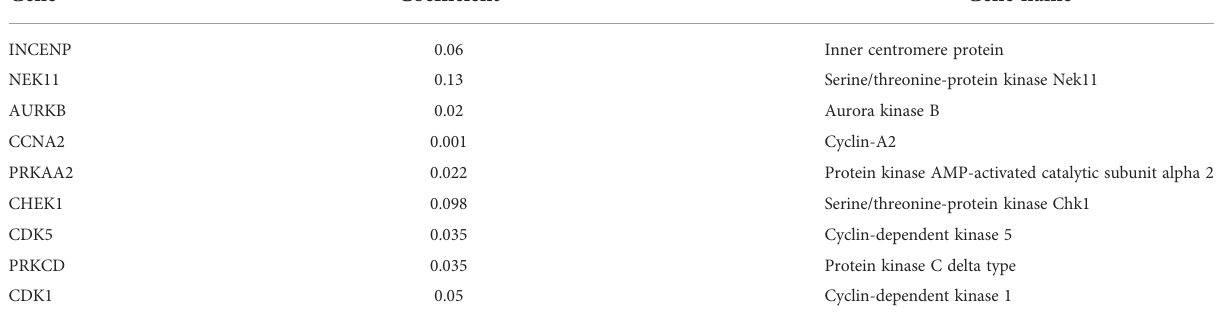
TABLE 2 Detail information of the prognostic gene